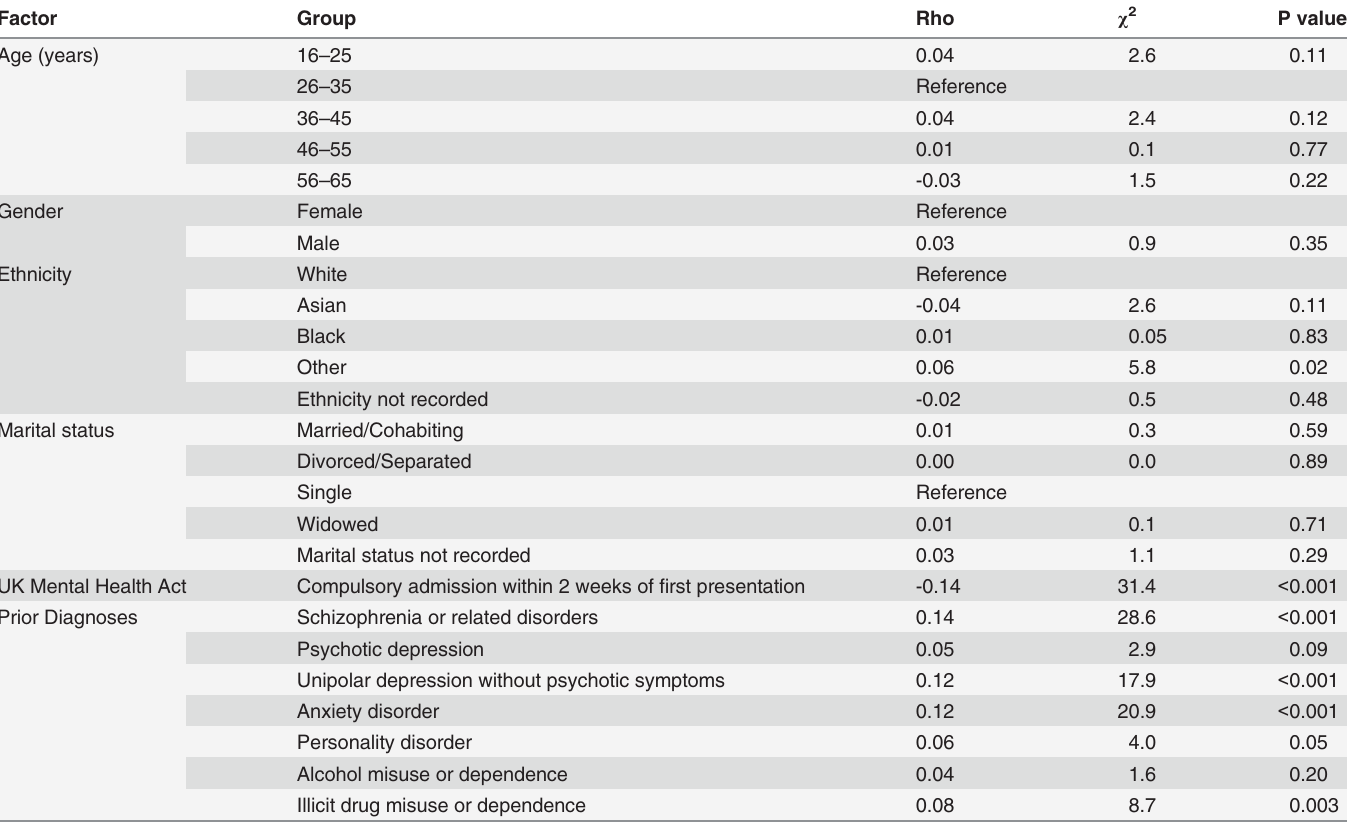
Table 3. Test of proportionality of hazards on Schoenfeld residuals for diagnostic